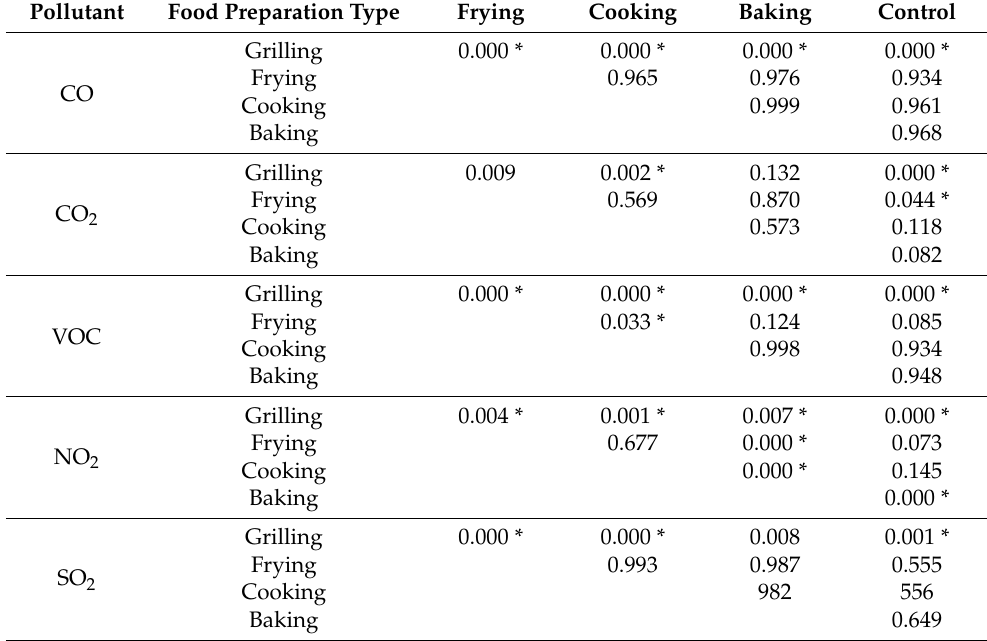
Table 6. Mean levels of pollutants in ambient air compared to their AQGs. Mean Concentration of the Study (ppm) AQG Pollutant